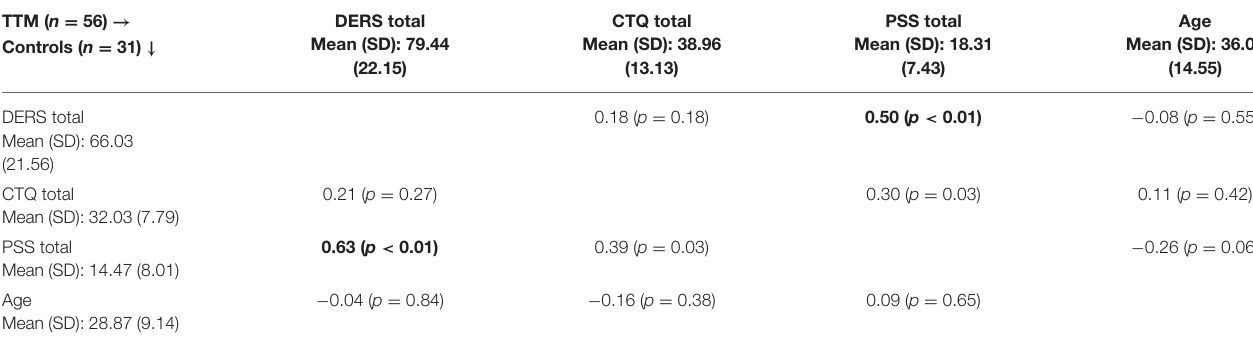
TABLE 1 | Correlations between total scores on the DERS, CTQ, PSS, and age per diagnostic group*. TTM ( n = 56) →